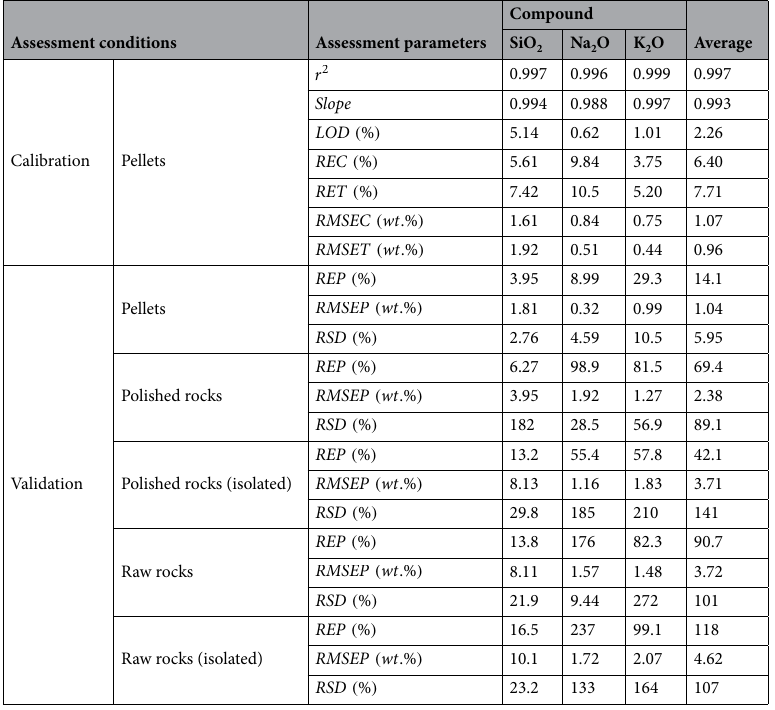
Table 2. Parameters assessing the calibration and prediction performances of the machine learning models for SiO 2 , Na 2 O and K 2